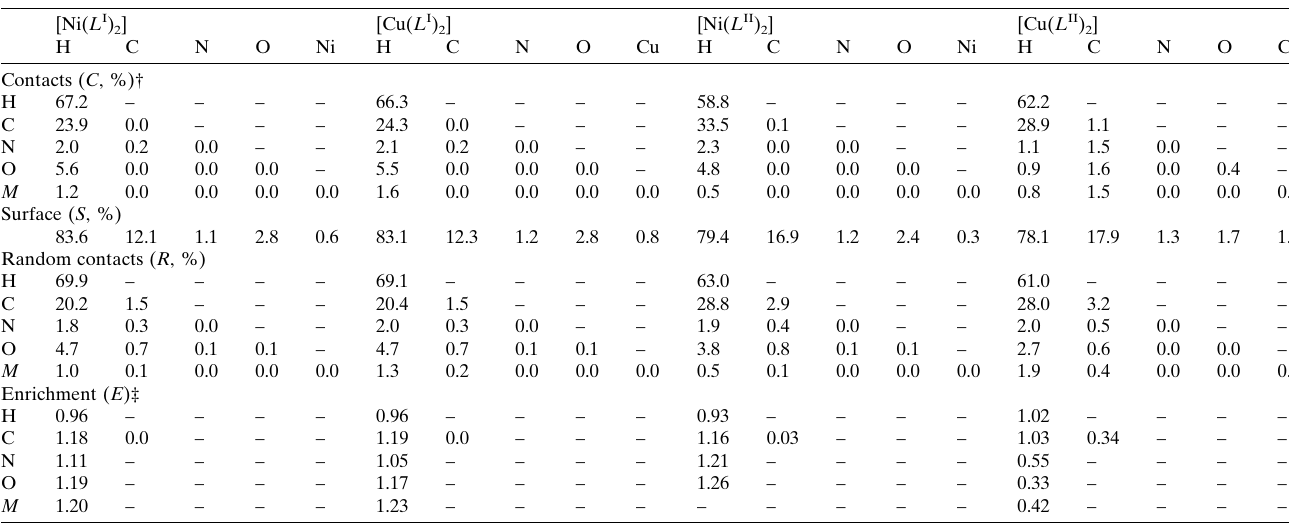
Table 3 Hirshfeld contact surfaces, derived ‘random contacts’ and ‘enrichment ratios’ for [Ni( L I,II ) 2 ] and [Cu( L I,II ) 2 ]. Fingerprint plots of the observed contacts are available in the Supporting